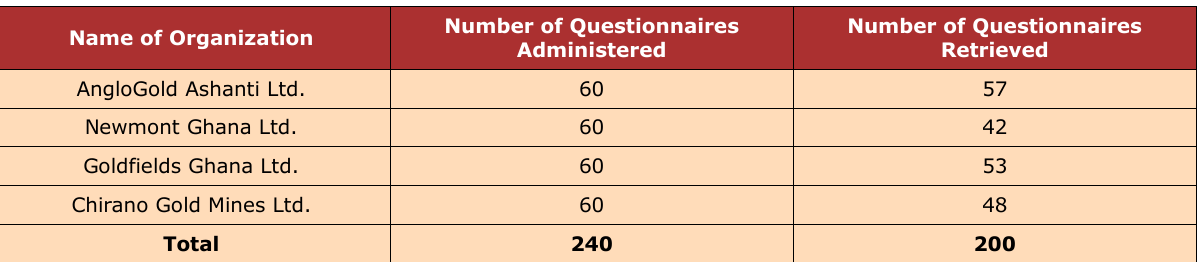
Table 3. Distribution of Name of Organization, Number of questionnaires administered and number of questionnaires